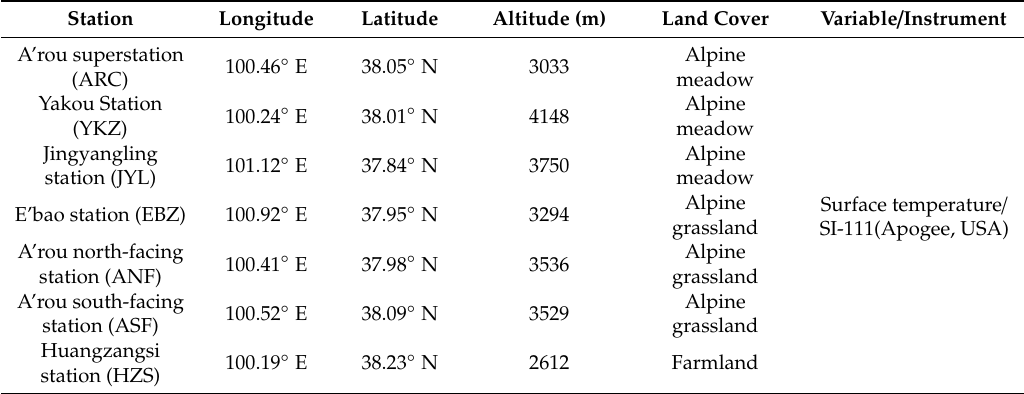
Figure 1. The study area (red rectangle line) and locations of land surface temperature (LST) stations. Table 1. Geolocation and surface type information of LST stations located in the study area.